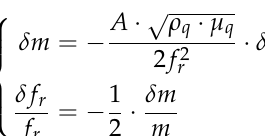
Figure 11. Surface of the QCM electrode before and after a single deposition of around 3 fluorescent particles. Images taken with the microscope Axio from Zeiss and a magnification of 2.5. ( a ): Before deposition and under red lightning ( b ): After deposition and under red lightning ( c ): After deposition and without red